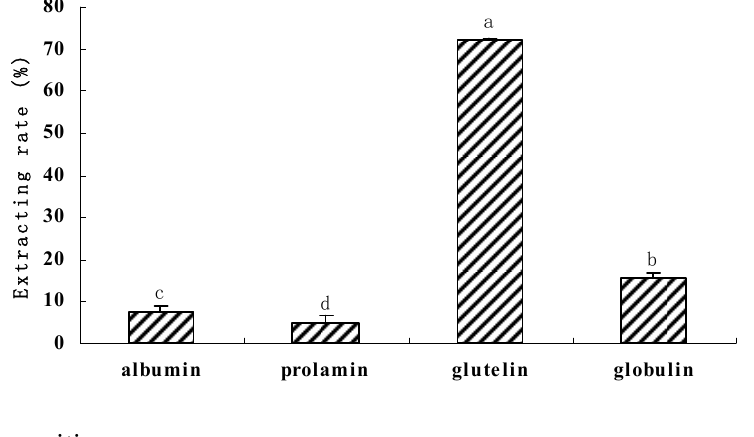
Figure 1. Contents of walnut proteins fractions. Bars indicate the standard deviation from triplicate determinations. Different letters indicate significant differences ( p <